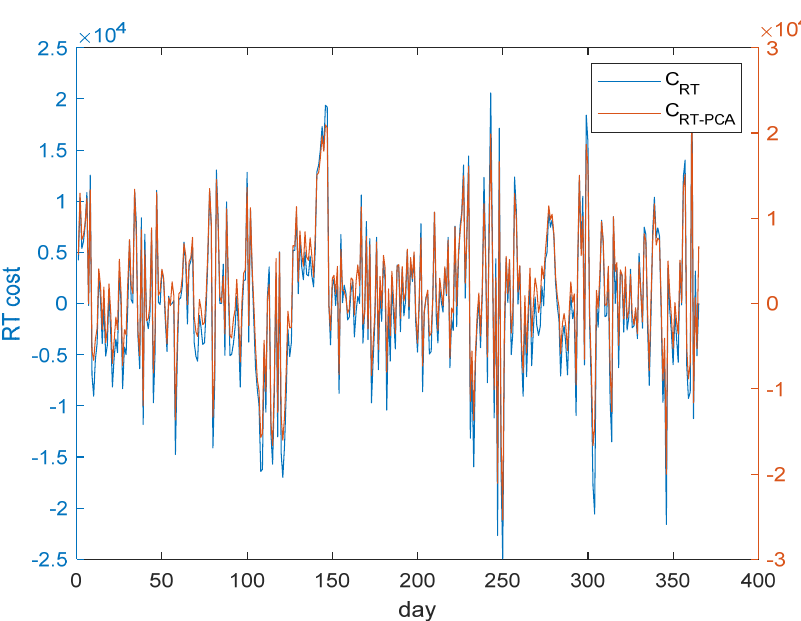
Figure 21. Electricity cost of the original load data and electricity cost of a typical load of the principal component extraction in the RT market. Table 6. Annual deviation assessment with three spot